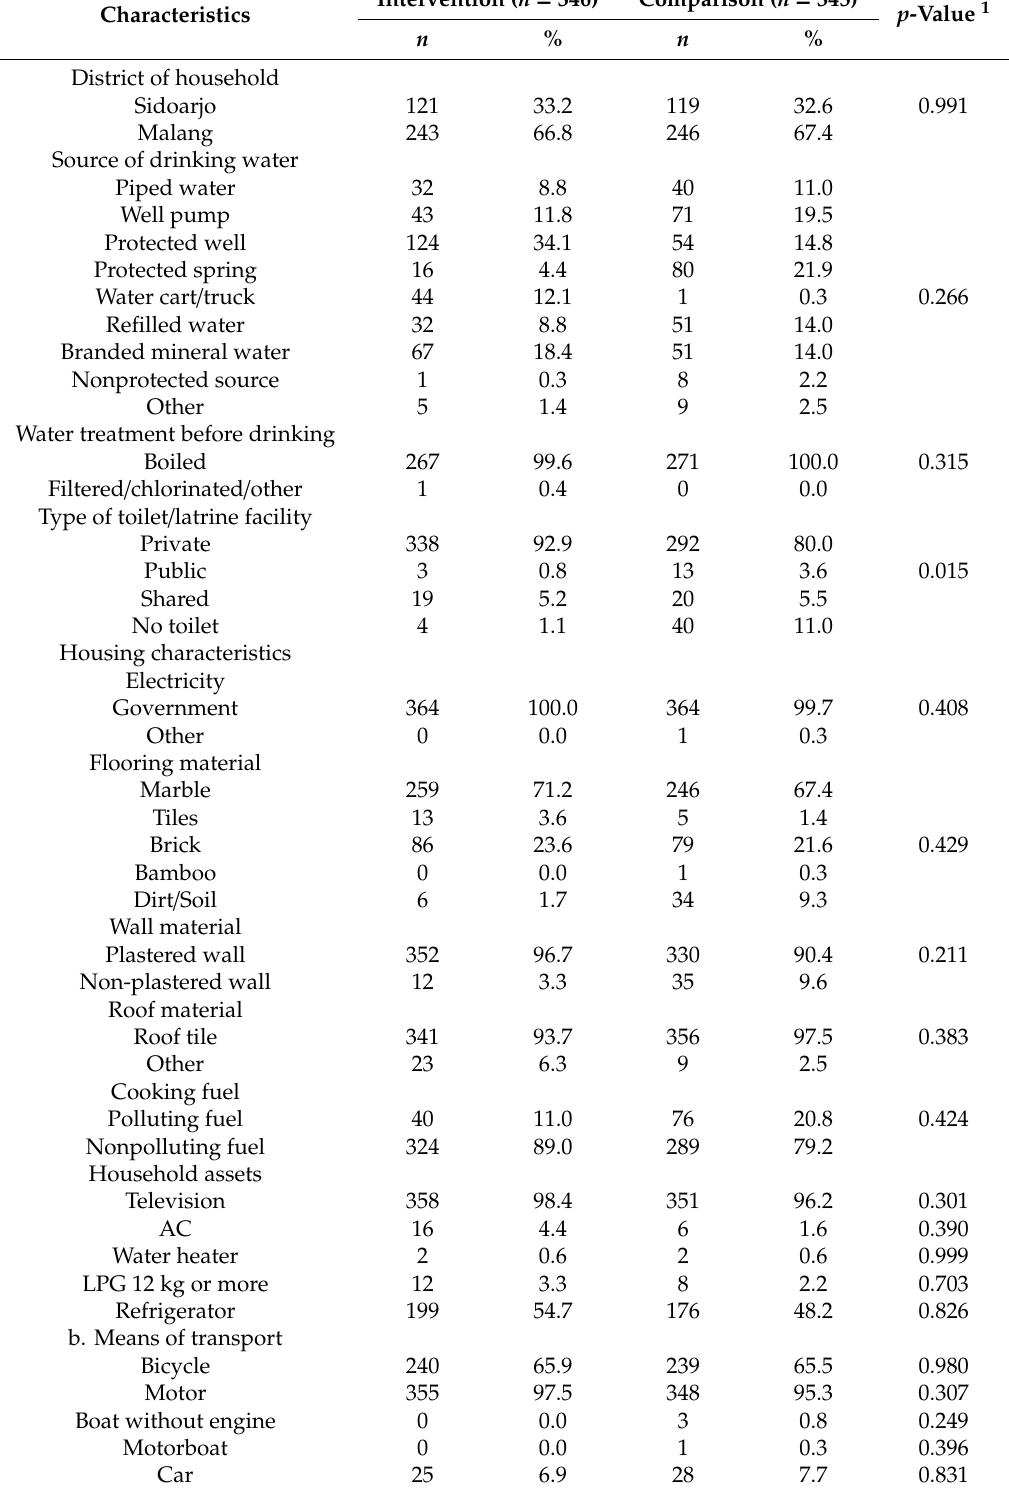
Table 2. Household characteristics of cohort mothers by treatment